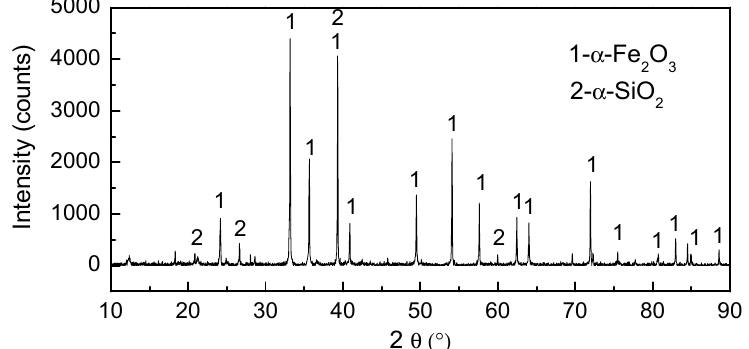
Figure 1. XRD pattern of the Brazilian iron ore particles.